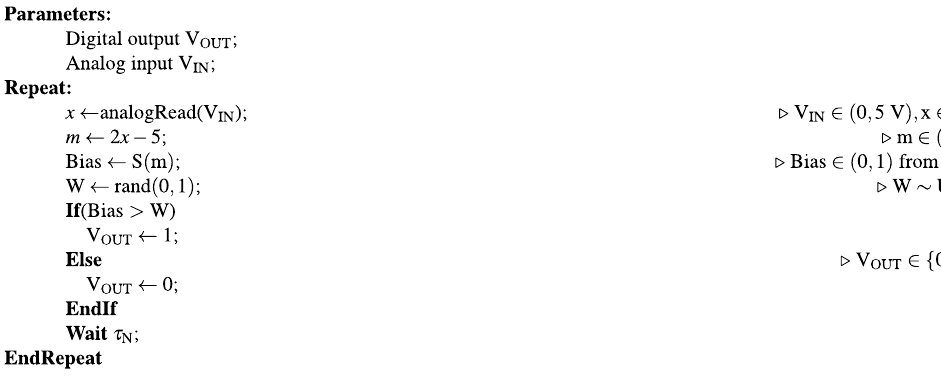
Algorithm 1. Pseudocode for